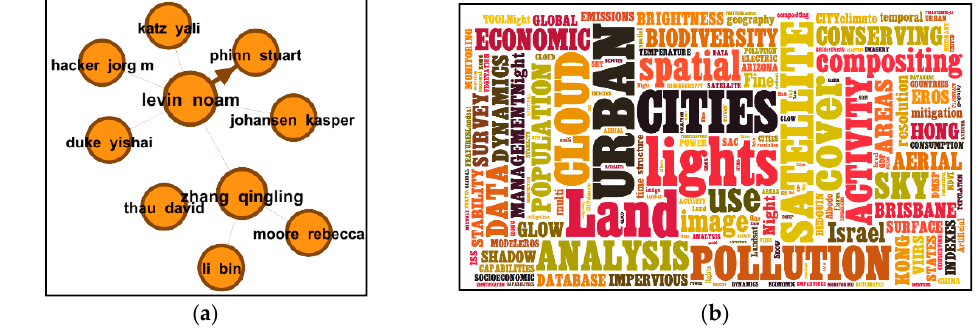
Figure 7. Levin, N.–Zhang, Q.L. research community: ( a ) co-author network; ( b ) related topics.